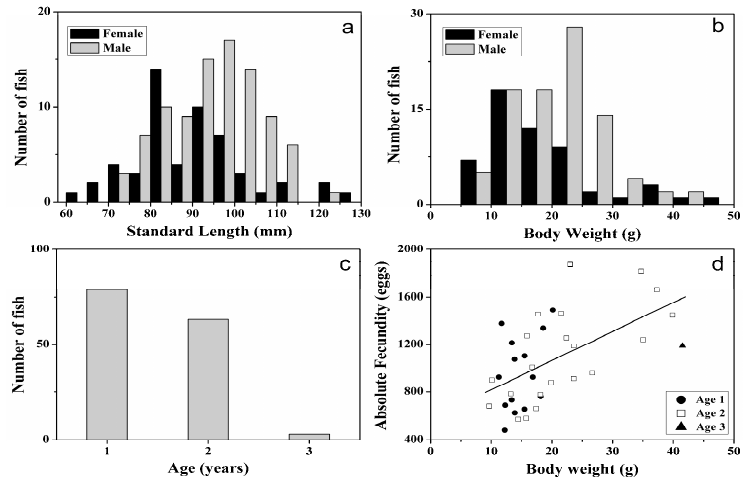
Figure 2. Distribution of standard length ( a ), body weight ( b ), age ( c ) and relationship of fecundity to body weight ( d ) of Odontobutis sinensis collected from Honghu Lake in 2016.